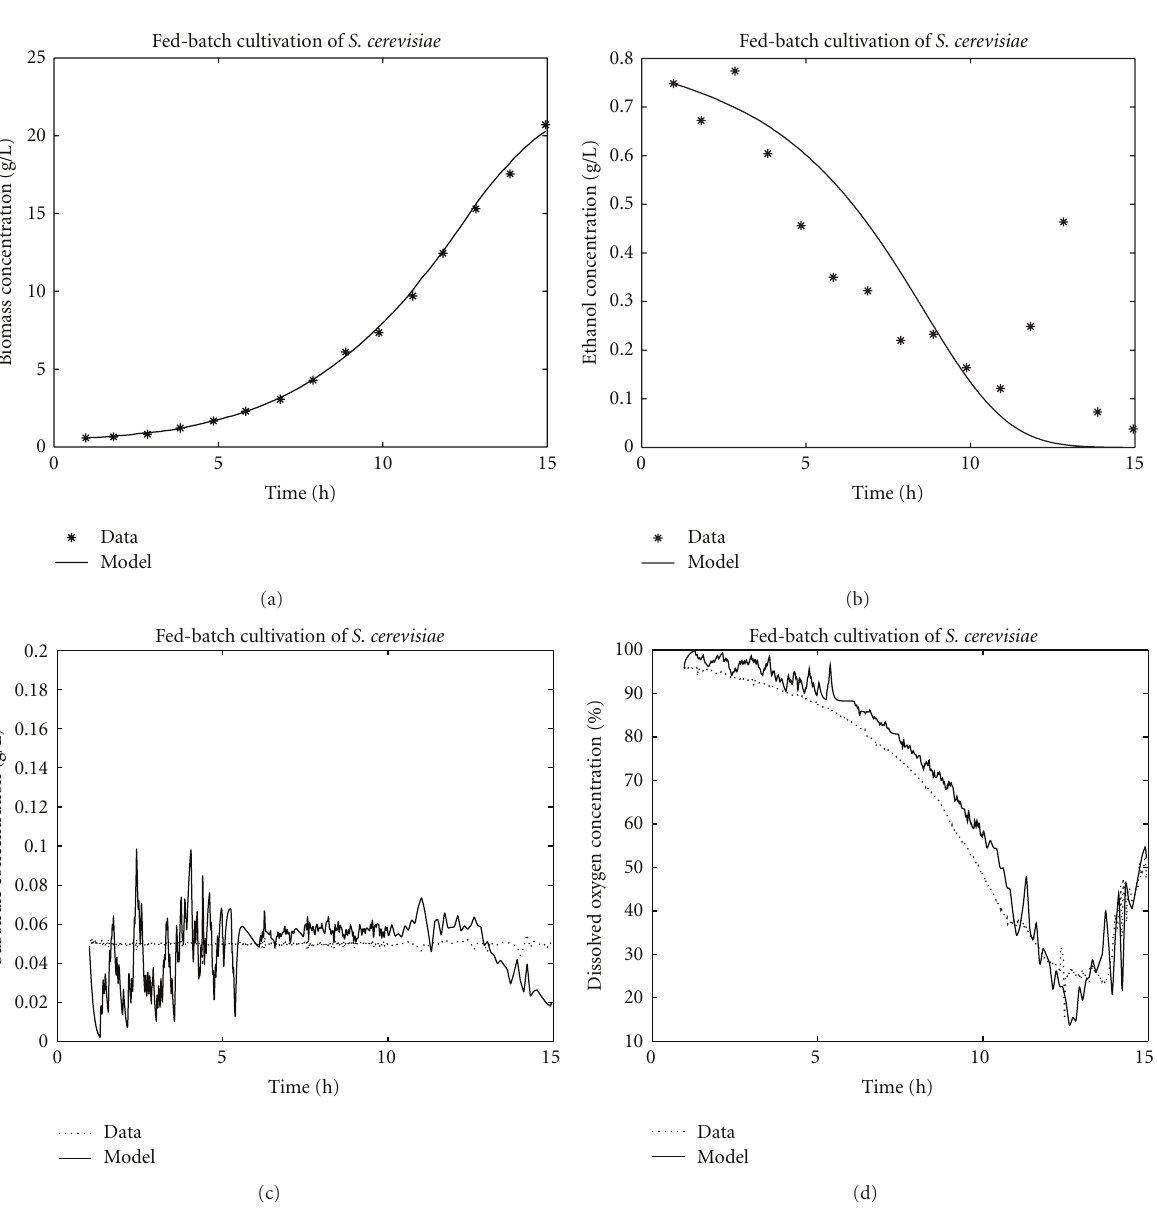
Figure 1: Model prediction compared to experimental data, respectively, for biomass, ethanol, substrate, and dissolved oxygen concen-